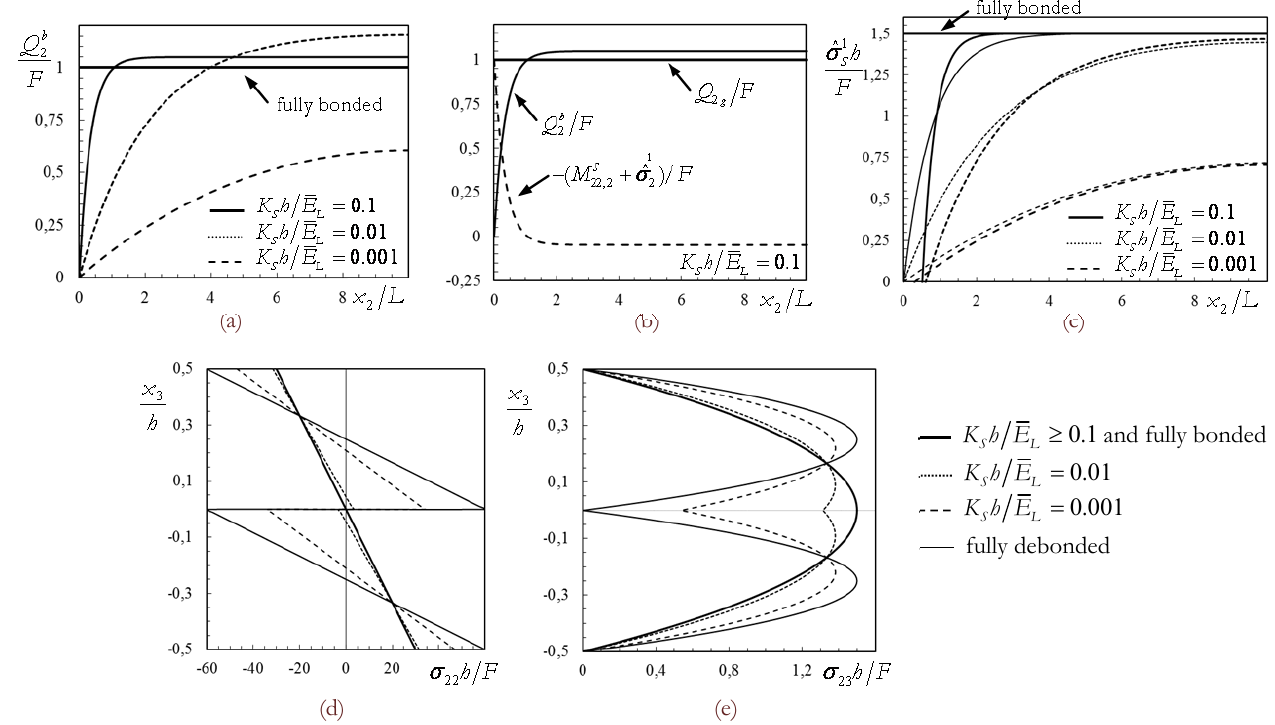
0  x and subjected to a concentrated force F at x L  . Two layers, unidirectionally reinforced Figure 3. Wide plate clamped at 2 2 ; interface at the with 25 / T midplane. (a) Transverse shear force along plate length. (b) Generalized transverse shear force, shear force and equilibrating resultants. (c) Interfacial tractions along plate length; homogenized model (thick lines), discrete-layer model (thin lines). (d-e) Bending (d) and 2 / x L  . (shear stresses calculated a posteriori from local shear (e) stresses through thickness at 2